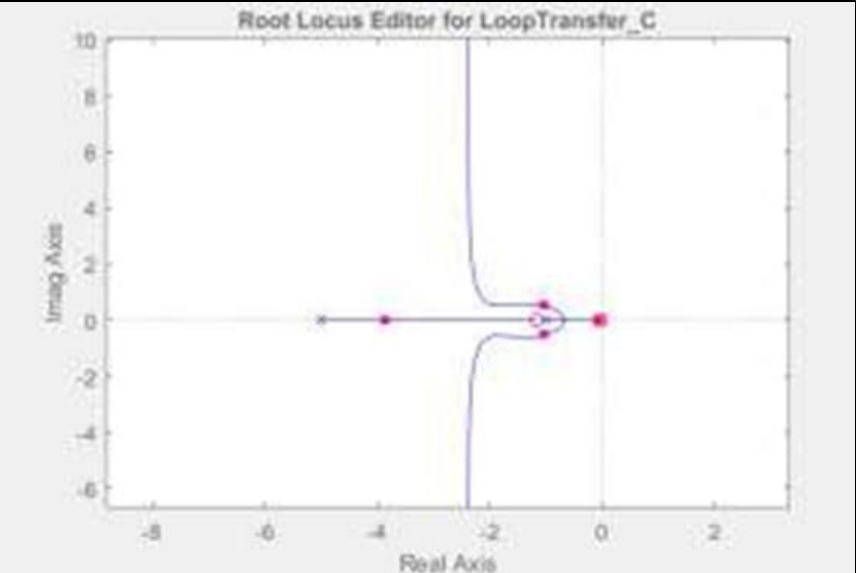
Figure 6: Pole Orientation for Gain in Transfer Function Source: Author,